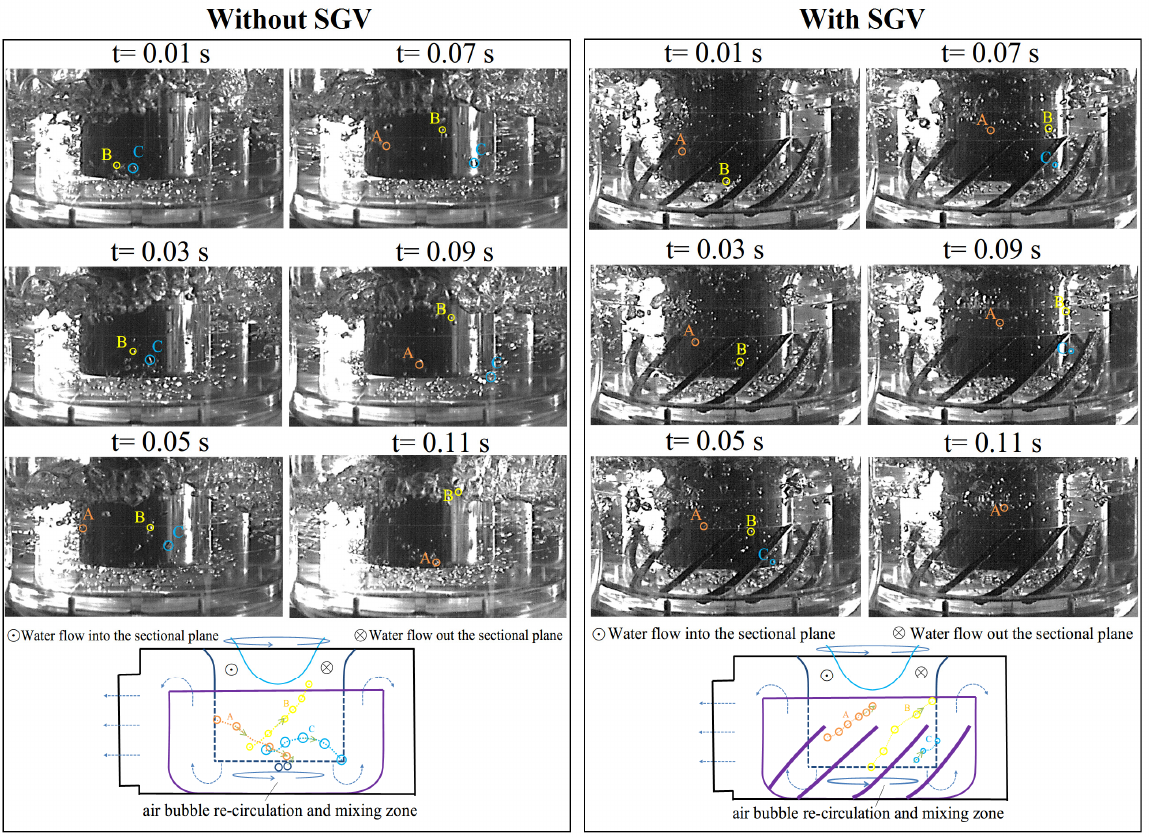
Figure 8. Drifting trajectories of air bubbles in test gullies without/with